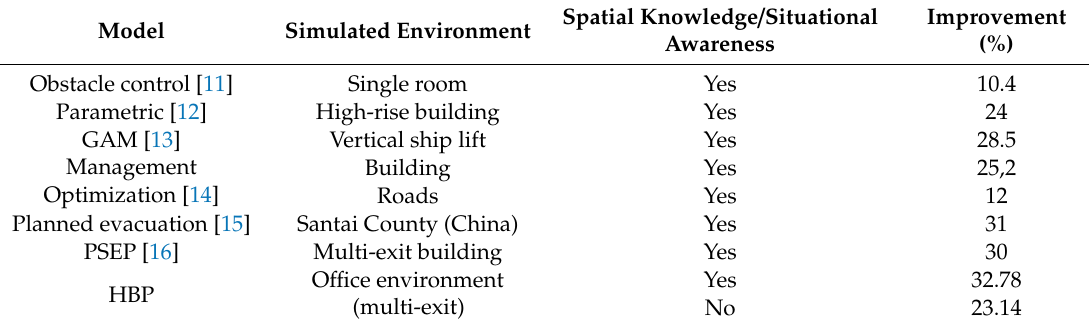
Table 6. Comparison of proposed model performance